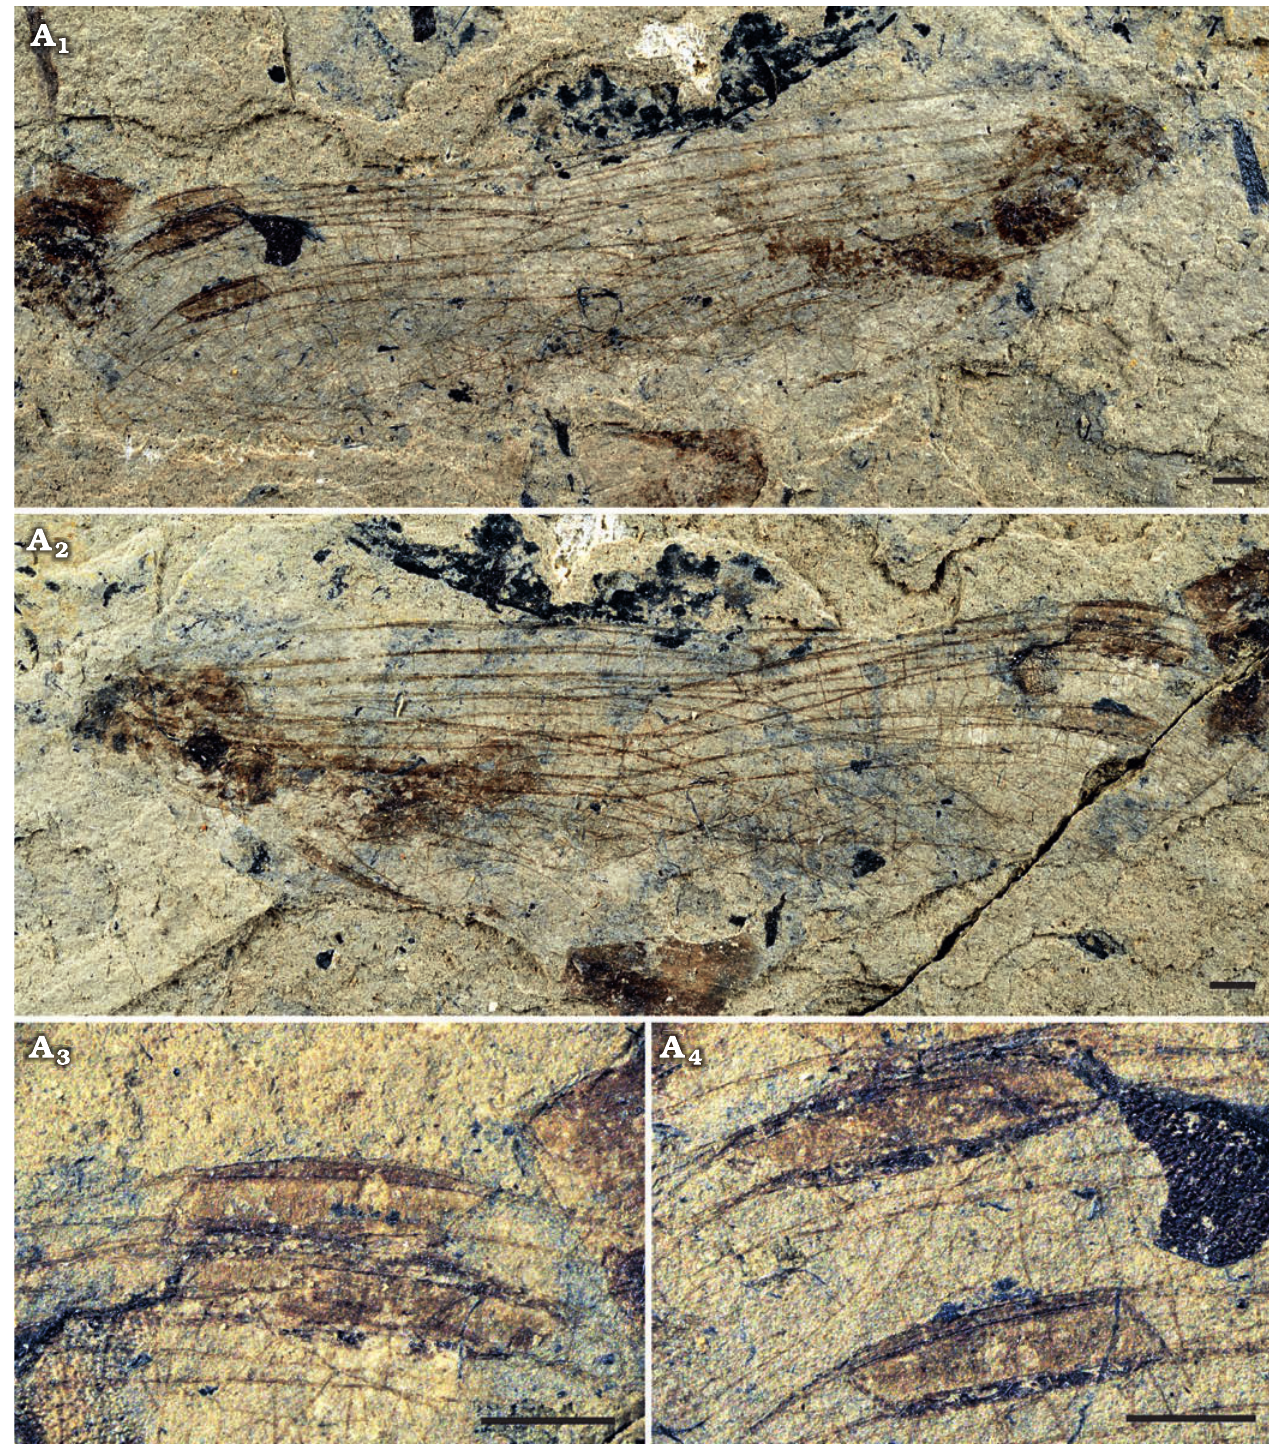
Fig. 1. Anisopteran odonatan Macrogomphus menatensis sp. nov., holotype MNT Nel 4173; from Paleocene, Menat, France. Imprint (A 1 ), counterimprint (A 2 ), details of pterostigmata (A 3 , A 4 ). Scale bars 1 Type locality : New quarry, Menat, Puy-de-Dôme, France. Type horizon : Middle Paleocene, Menat Basin. Material .—Holotype only.